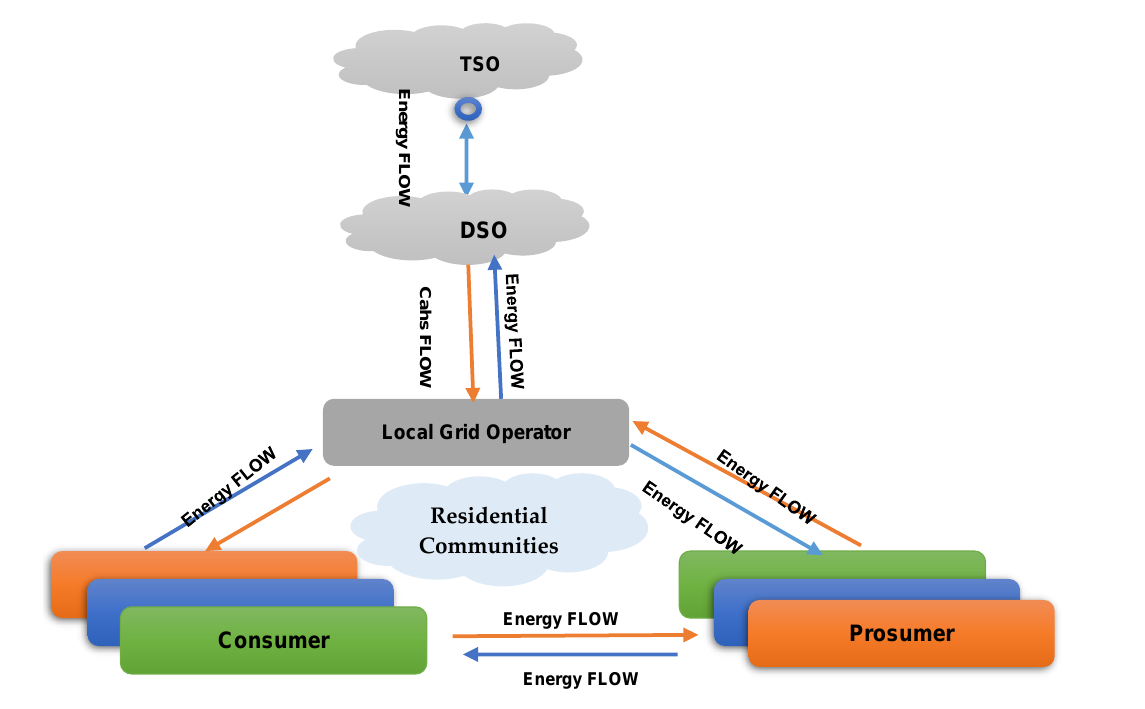
Figure 7. Infrastructure-based energy trading